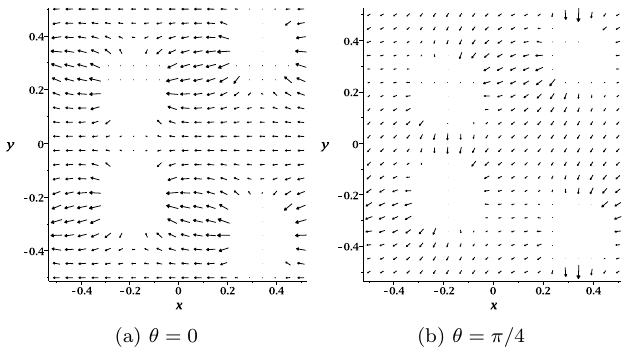
Figure 9. The flux distribution inside Q (0 , 0) for λ k = 0 . 01, γ k = 100, β k = − 100, θ = 0; π/ 4.